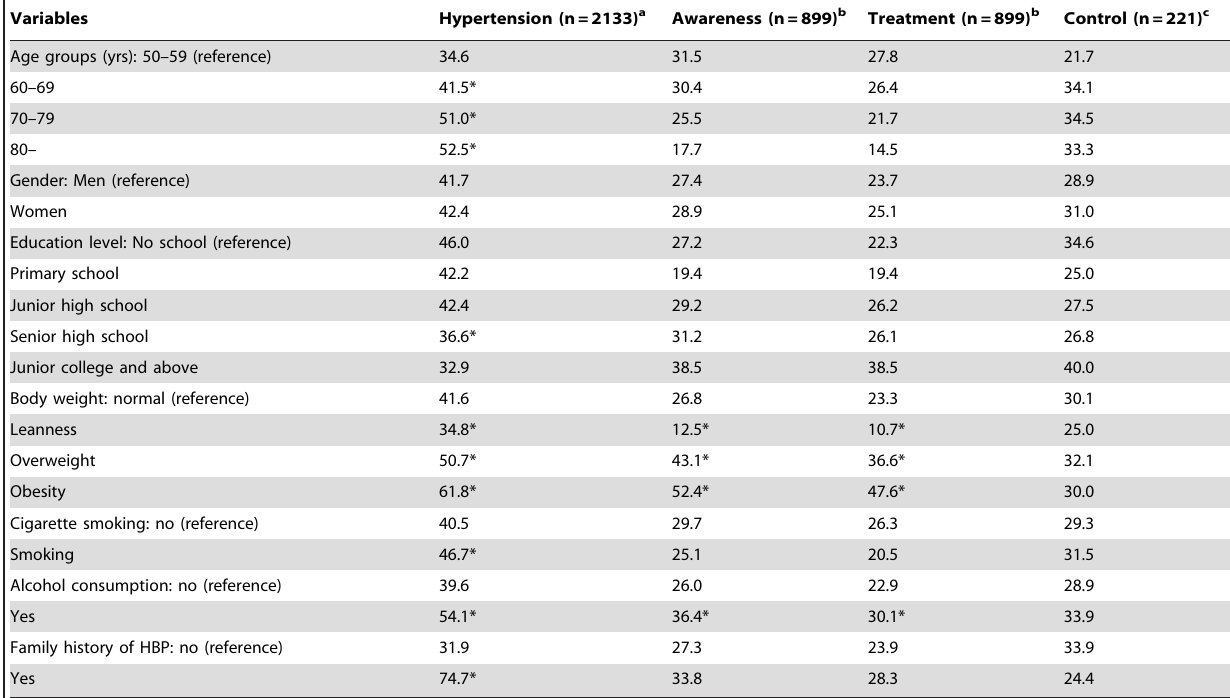
Table 2. Percentage (%) of awareness, treatment and control of hypertension by socio-demographics and those with and without risk